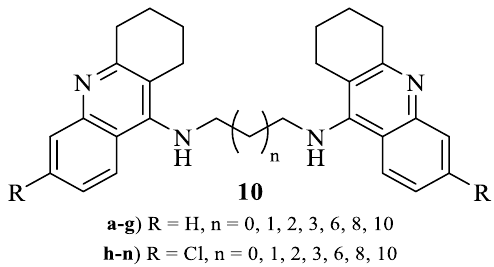
Figure 2. Structure of 1,2,3,4-tetrahydroacridine dimers ( 10 ).